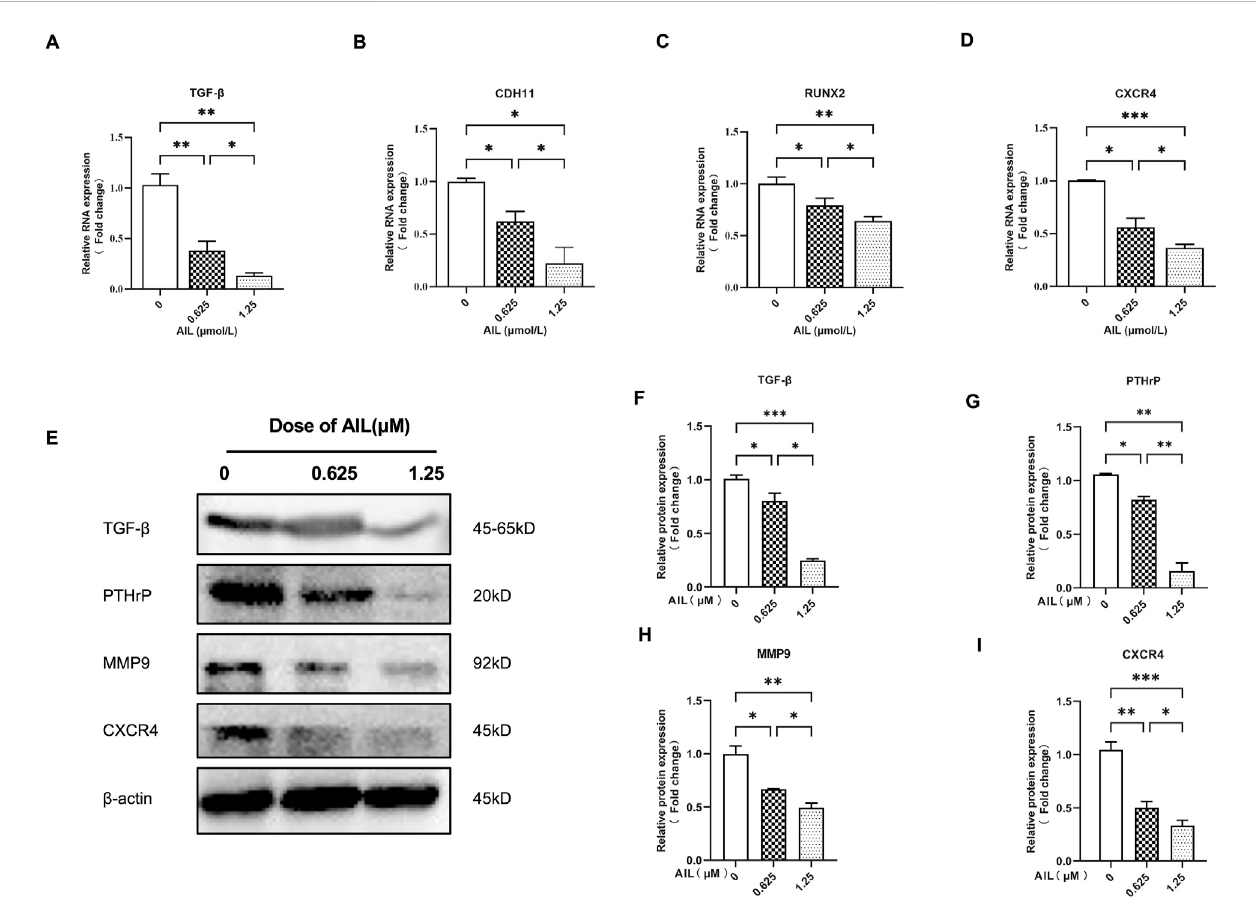
InMDA-MB-231cells,AILdownregulatestheexpressionlevelsofthegenesandproteinmarkerslinkedtoosteoclastdevelopment. (A – D) TheMDA-MB- 231 cells were treated using varying AIL concentrations, RNA was collected, and qPCR analysis indicated that the expression levels of TGF- β , CDH11, RUNX2, CXCR4 genes involved in osteoclast formation was down-regulated. The 2 ^ ΔΔ CT method was utilized to evaluate the data, and Table 1 contains a list of the individual primers that were employed. (E) After subjecting MDA-MB-231 cells to differing AIL concentrations, the total protein content was extracted, andWesternblotanalysiswasemployedtoidentifytheexpressionlevelsofTGF- β ,PTHrP,MMP9,CXCR4,theproteinmarkersrelatedtoosteoclastformation. (F – I) Western blotting experiments were used to determine the osteoclast-related protein expression following treatment with various doses of AIL. The mean ± SD of the three replicates were used to express all the data. * p < 0.05, ** p < 0.01, *** p < 0.001, in comparison to the control